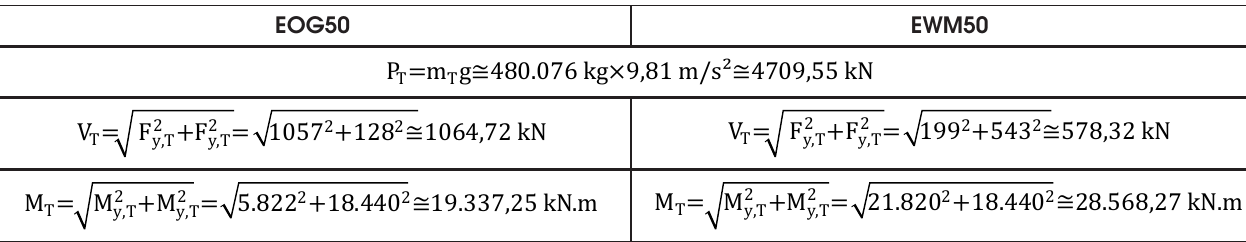
Loads considered at the top of the tower for a 5 MW EOG50